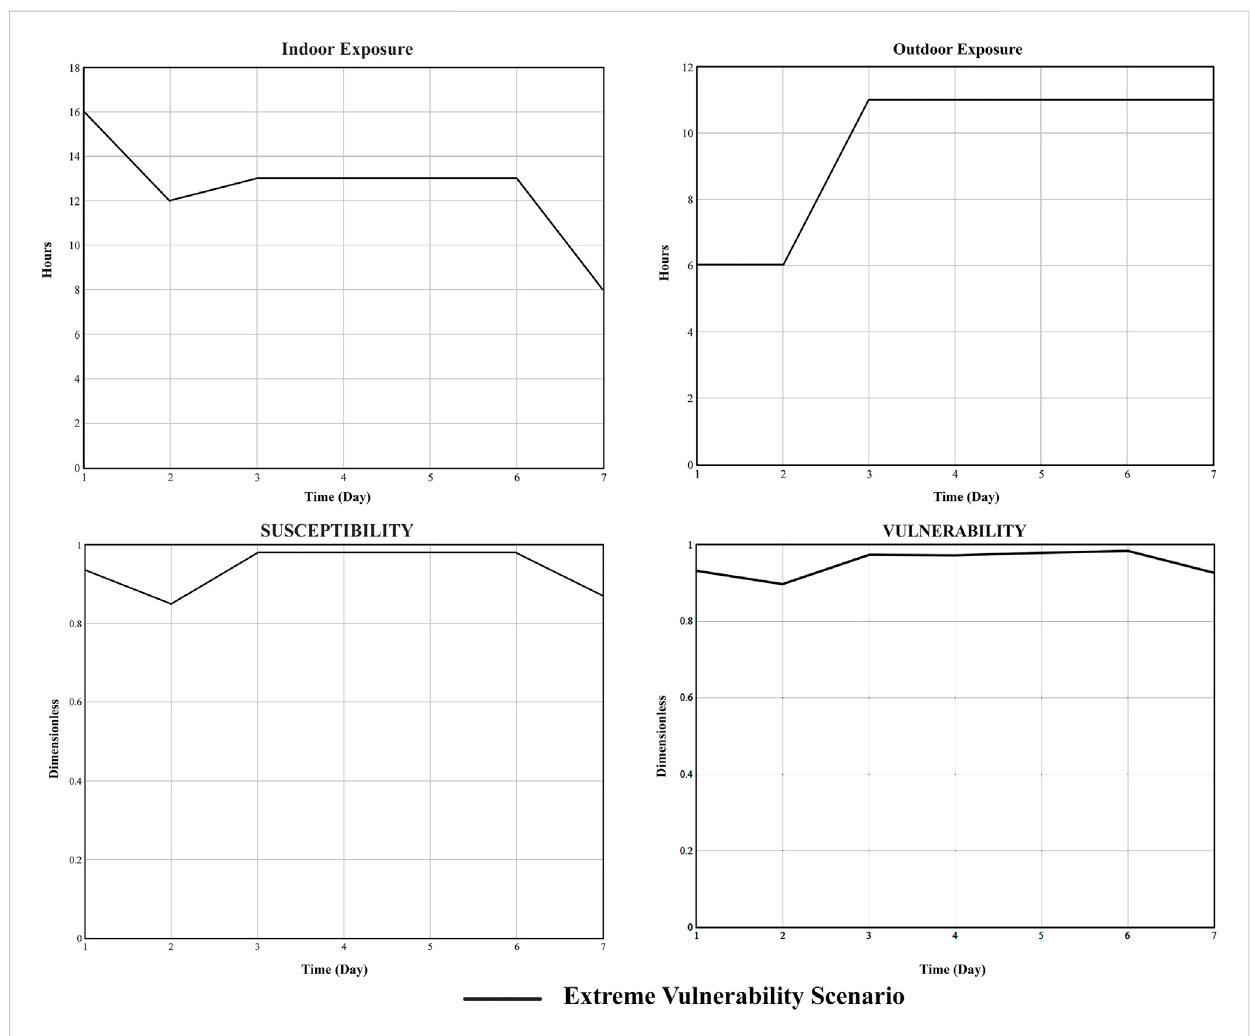
FIGURE 8 Results for the extreme vulnerability scenario and indoor and outdoor exposure (no. of consecutive hours where exposure is above comfort threshold) from the simulation